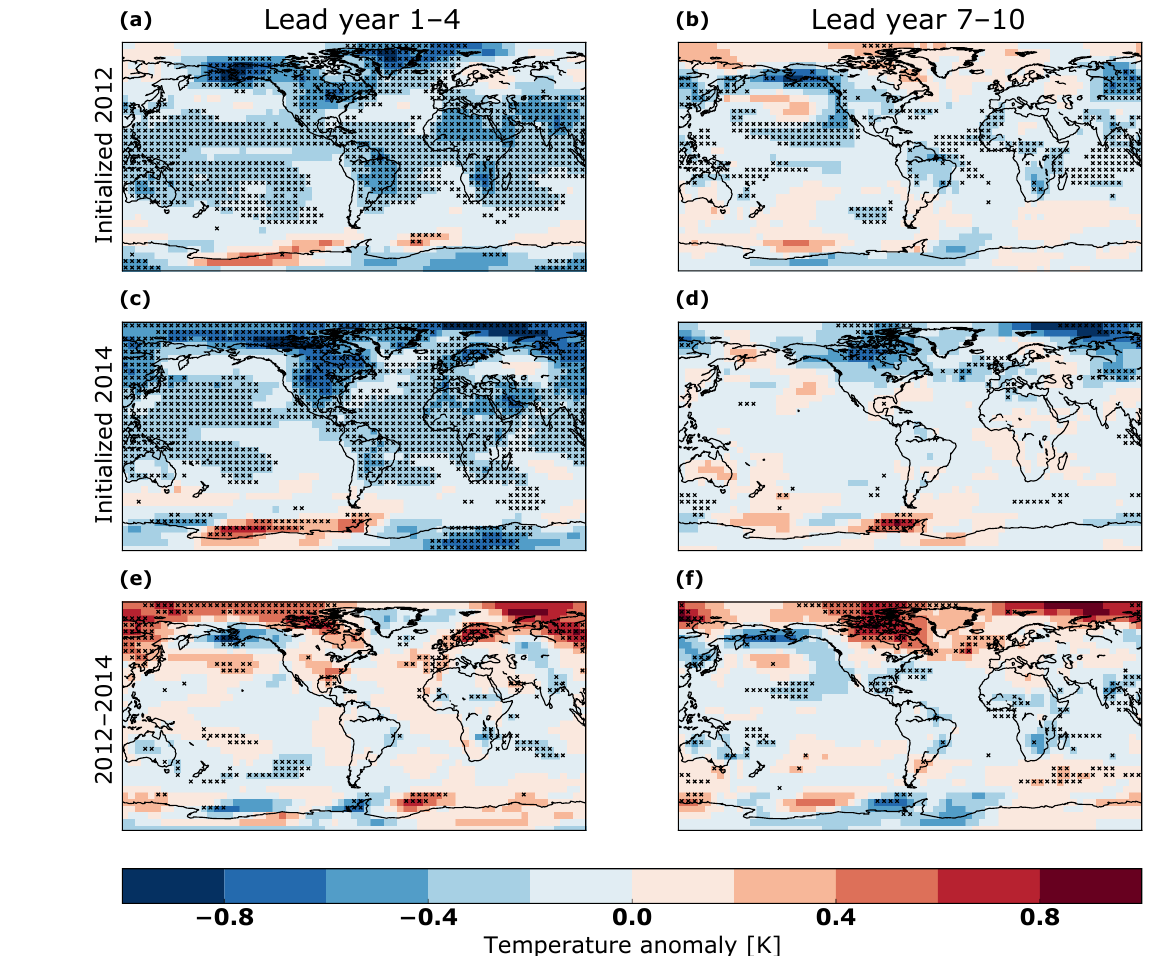
Figure 3. Differences in ensemble mean forecasts of TAS for prediction years 1–4 (a, c, e) and 7–10 (b, d, f) . Top row (a, b) shows exp- 2012 (Pinatubo-2012 – b1-2012), middle row (c, d) shows exp-2014 (Pinatubo-2014 – b1-2014), and bottom row (e, f) shows the difference between the two upper (exp-2012 – exp-2014). Crosses denote values significantly different from zero exceeding a 5% level.